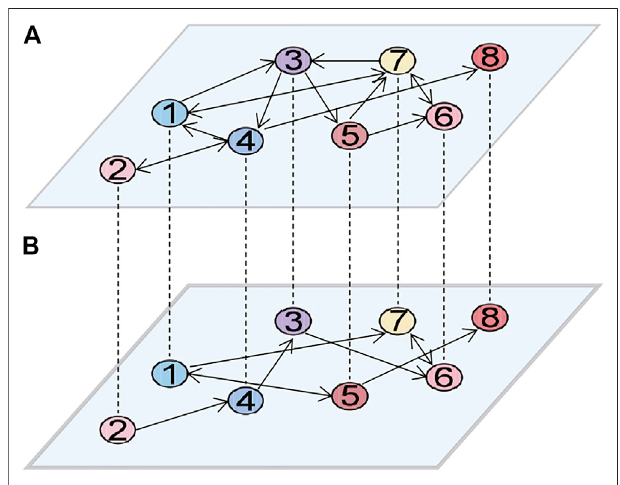
FIGURE 1 | Illustration of interdependent directed networks. Directed networks A and B are coupled by dependency links (dotted